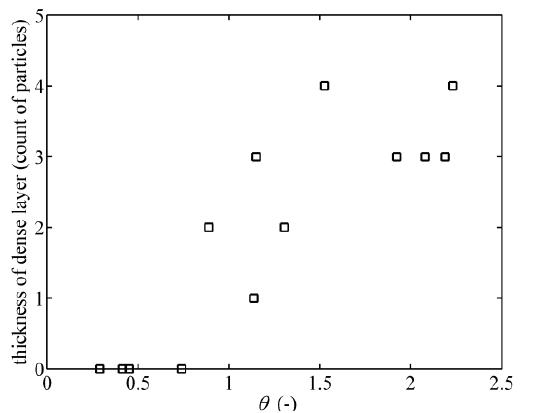
Fig. 2. Observed thickness of dense part of transport layer counted as multiple of grain size related to measured dimensionless bed shear stress (bed Shields parameter)